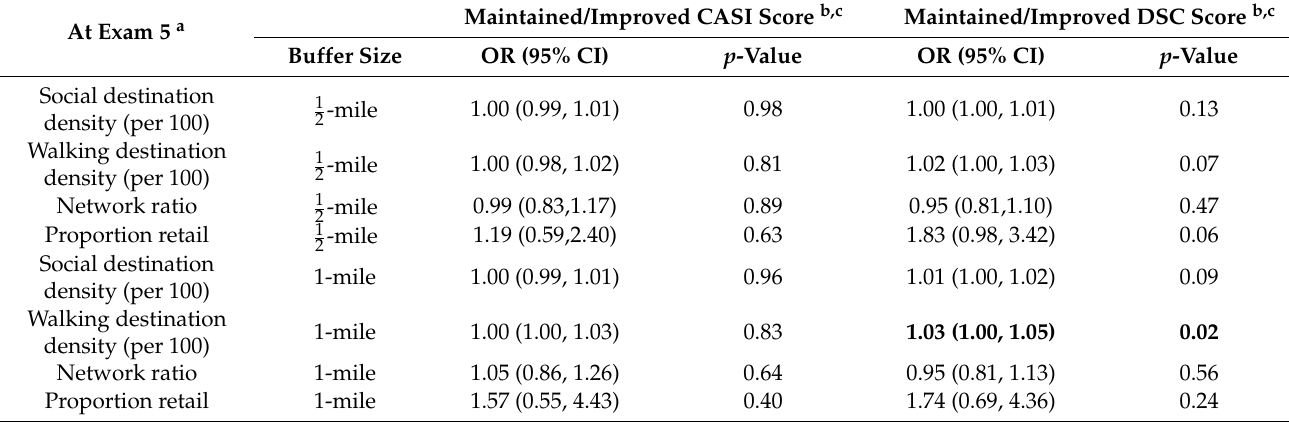
Table 4. Adjusted association between continuous built environment measures and dichotomous cognitive change